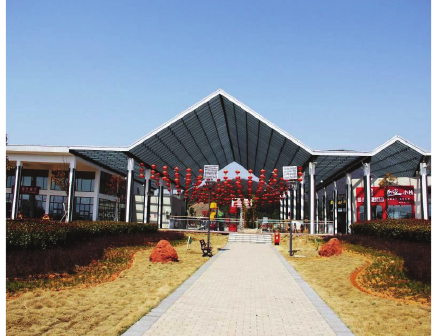
Figure 10: Maximizing the glass area facing the south.